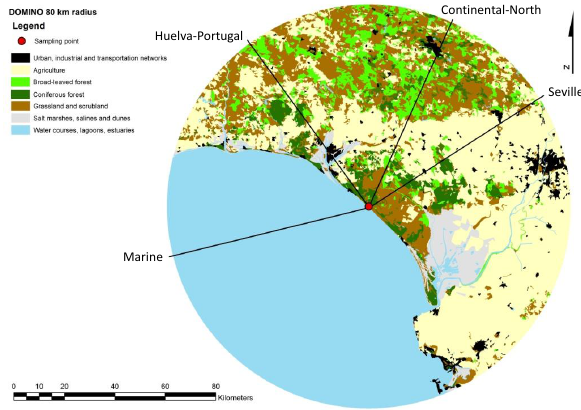
Fig. 2. Distribution of land use within 80km of the measurement site. Black lines indicate the last part of the back trajectories cluster means at 100m.